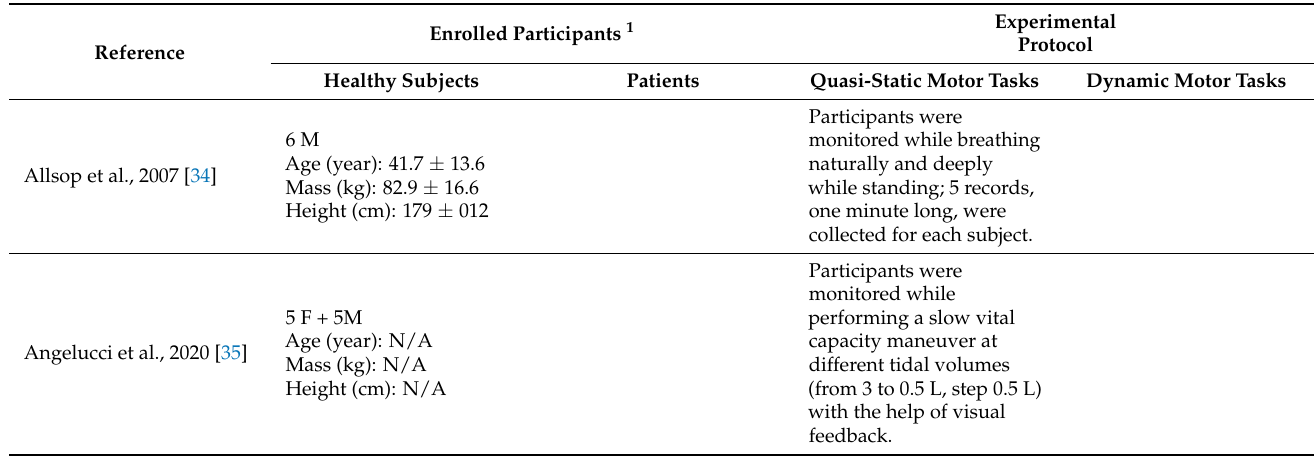
Table 3. Enrolled participants and experimental